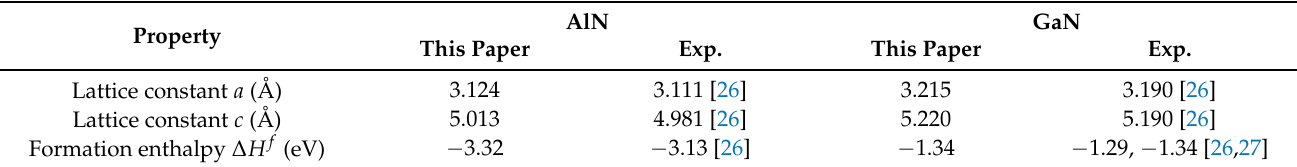
Table 1. Calculated properties of AlN and GaN bulk crystal compared with relevant experimen- tal